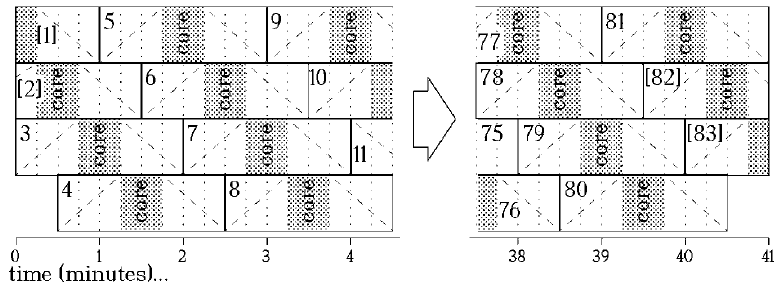
Figure 11: Zero Crossing : the System of Edition